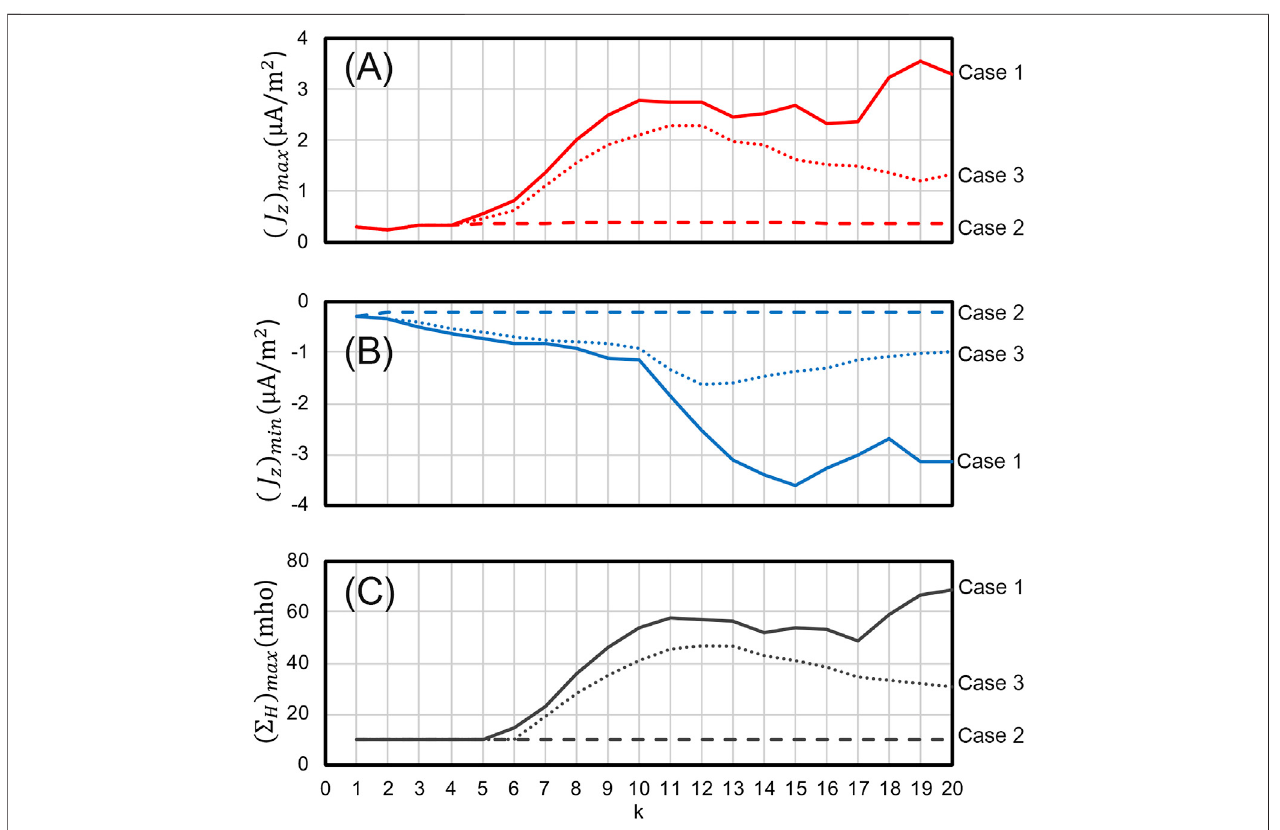
FIGURE 5 | The time evolution of (A) ( J z ) max , (B) ( J z ) min , and (C) ( Σ H ) max obtained from the simulations of Case 1 (the solid curves), Case 2 (the dashed curves), and Case 3 (the dotted curves).